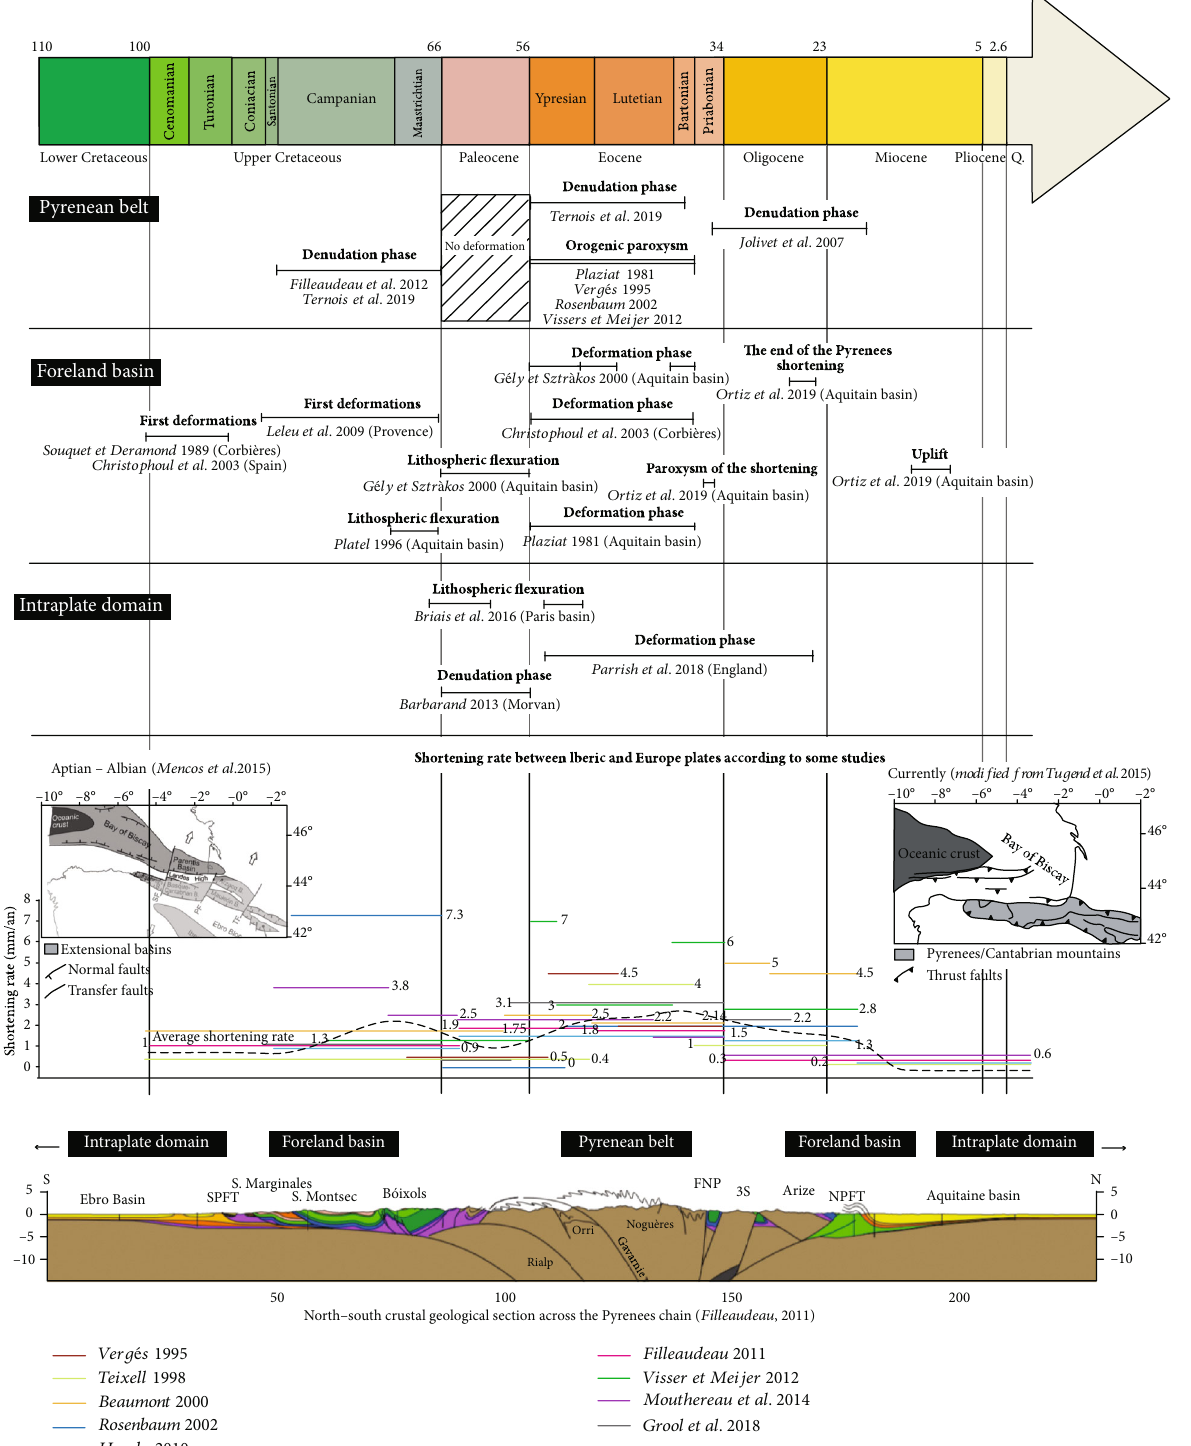
Figure 3: Summary of previous studies on the age of deformations related to the formation of the Pyrenees in various domains (orogenic belt, foreland basin, and intraplate domains) and on the rate of shortening between Iberia and European plates. While the deformation events at the plate boundary appear to be relatively short in time and correspond to high rates of shortening between both plates, the foreland basins show a continuous deformation from the upper Cretaceous to the Eocene [12, 37 – 44, 47 – 54, 88, 90, 115 –